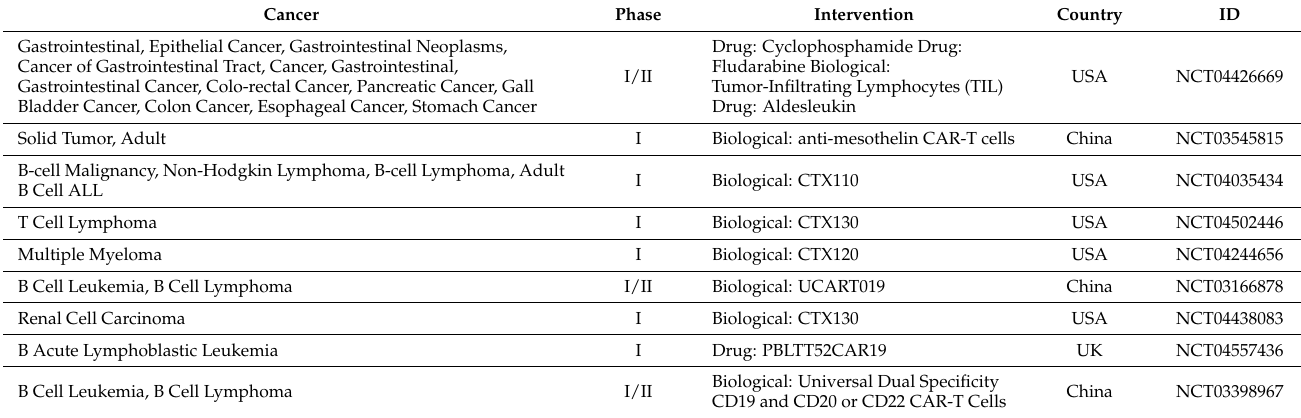
Table 5. Table that summarizes the clinical trials employing CRISPR/Cas9 for various types of cancer. Cancer Phase Intervention Country